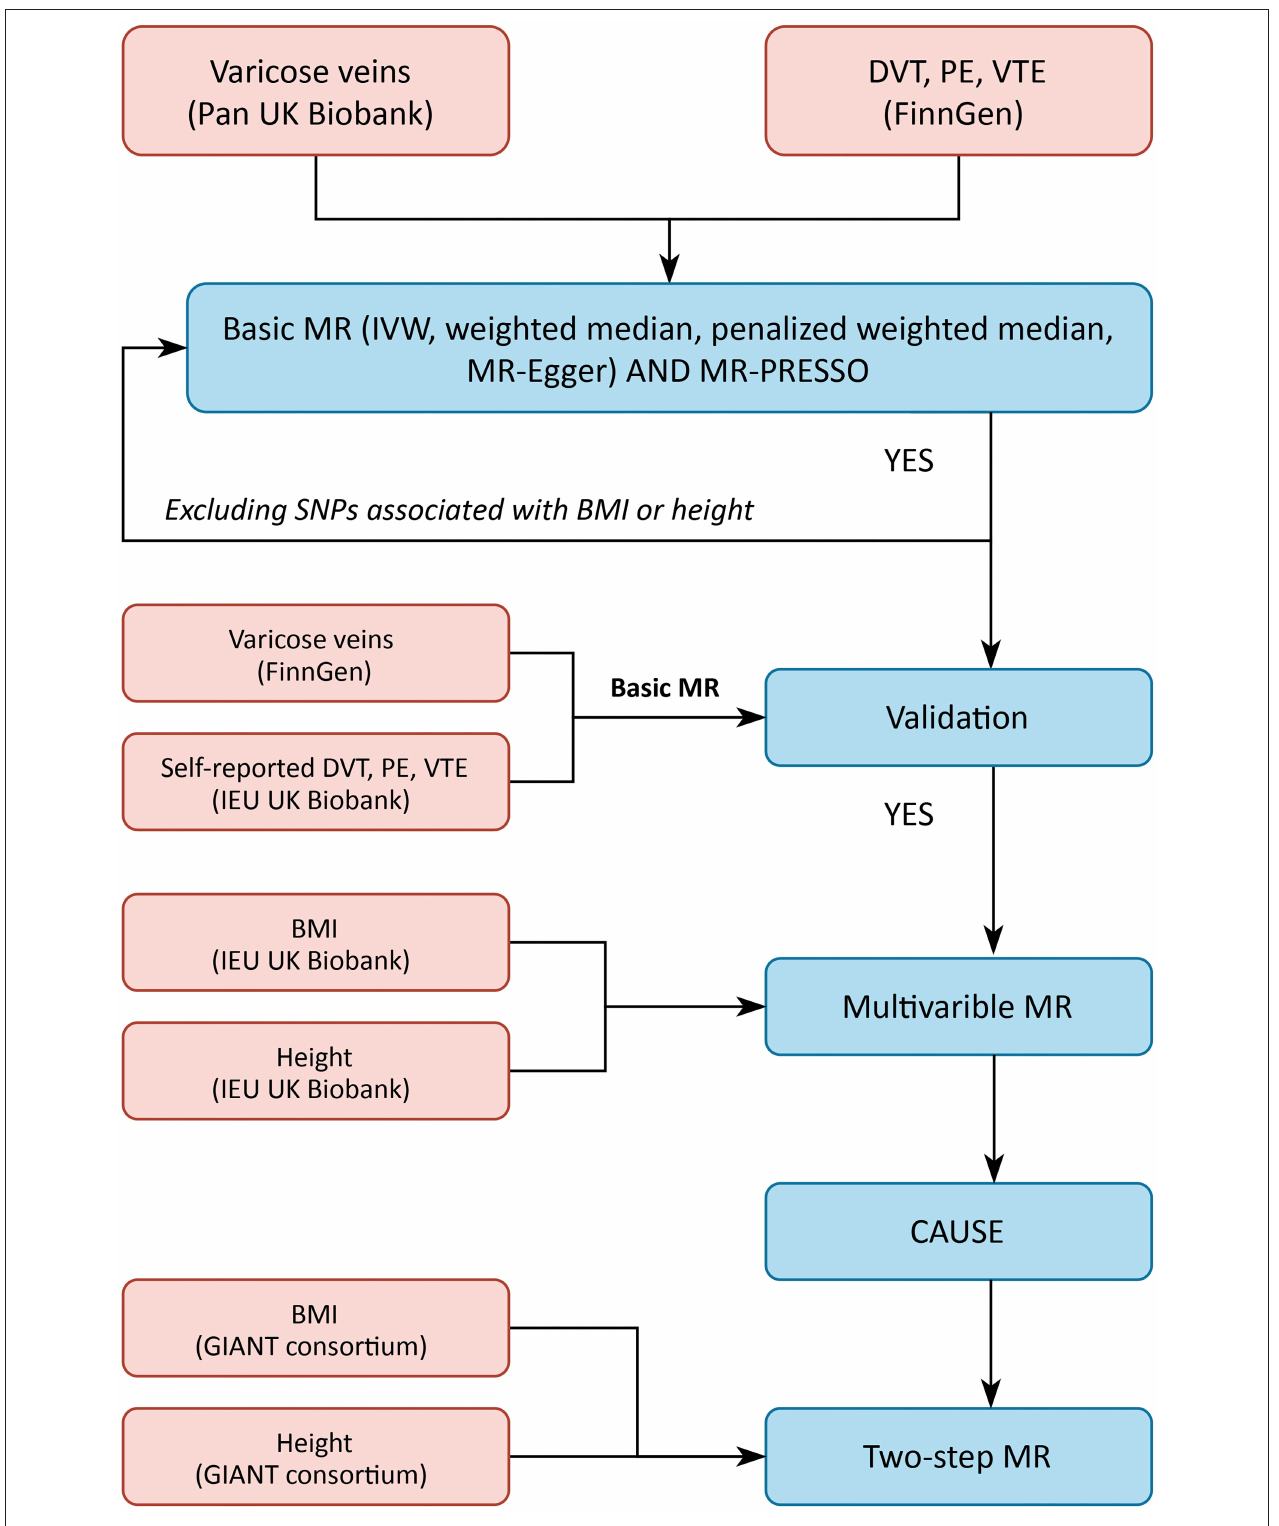
FIGURE 2 | Flow of the study. CAUSE, Causal Analysis Using Summary Effect estimates; IVW, inverse-variance weighted; MR, Mendelian randomization; MR-PRESSO, Mendelian randomization pleiotropy residual sum and outlier.